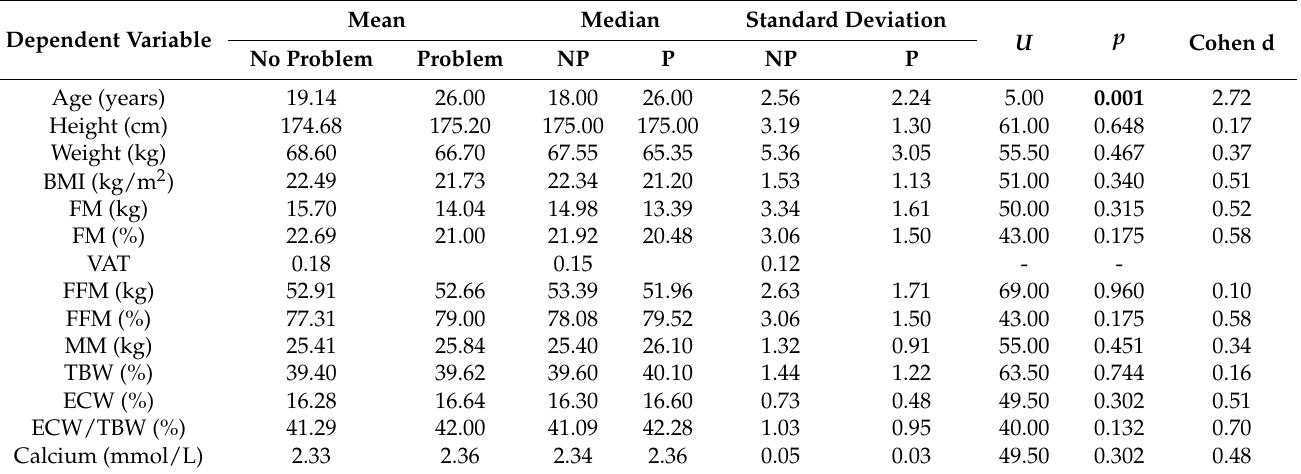
Table 1. Differences between kayakers who have disorders of the monthly cycle (problem n = 5) and without such problems (no problem n = 28); numerical variables (Mann–Whitney U